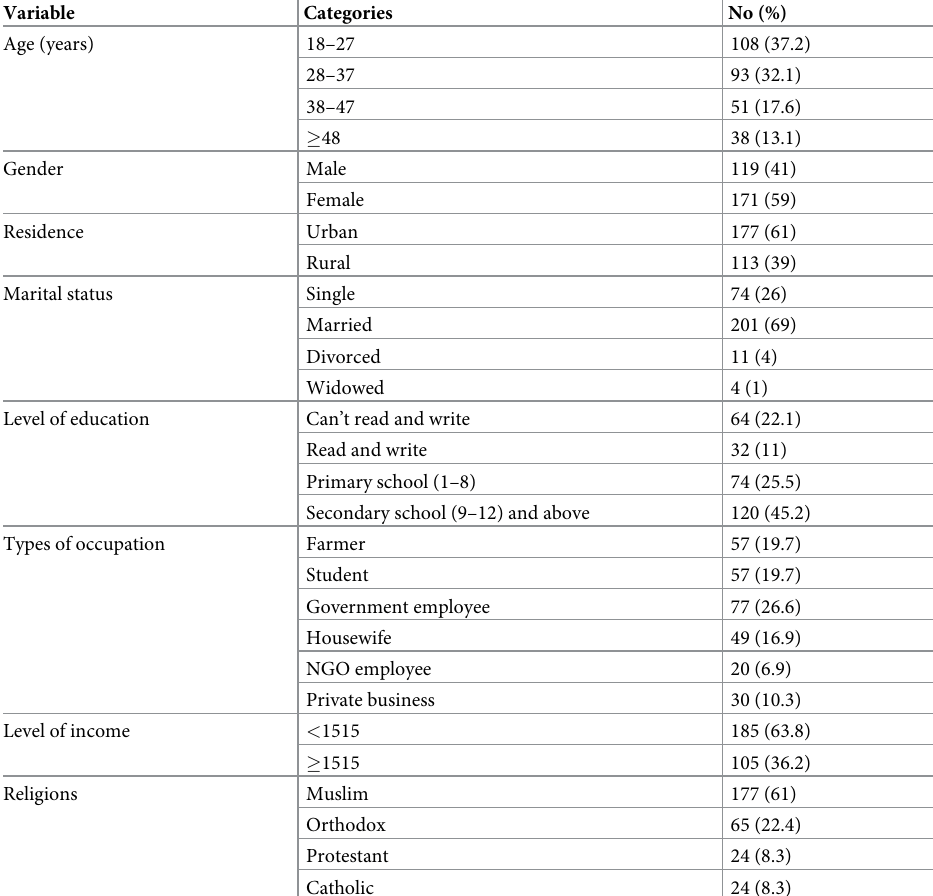
Table 1. Socio-demographic characteristics of the dental caries patients attended at Hiwot comprehensive Fana specialized university hospital dental clinic (N = 290), Eastern Ethiopia from April to June 2021.